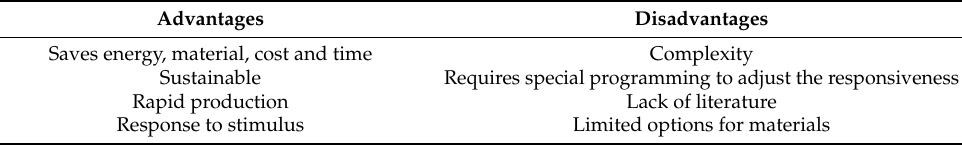
Table 1. Summary of Advantages and Disadvantages of 4D Printing. Advantages